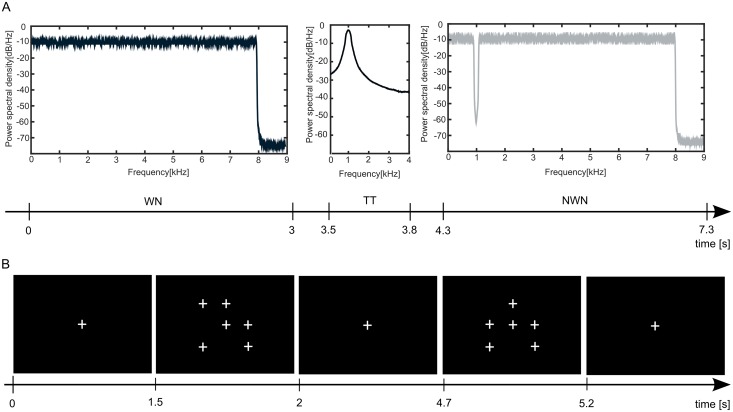
Overview of the stimulation paradigm.Subjects were presented with visual and auditory stimuli simultaneously. See text for a detailed description of the stimulation. (A) Auditory stimulation, comprising a white noise (WN) masking stimulus, a test tone (TT) and a notched white noise (NWN) masking stimulus. (B) Visual stimulation, consisting of patterns of small white crosses presented on the screen. As the duration for the presentation of the fixation cross (first stimulus) was randomly jittered between 0.2 and 3 s, the displayed timing of the stimuli represents only one possible example. On one half of the trials, subjects were instructed to concentrate on the auditory input to detect small changes of loudness in the sounds. On the other half of the trials subjects were instructed to concentrate on the visual input and detect target stimuli on the screen.